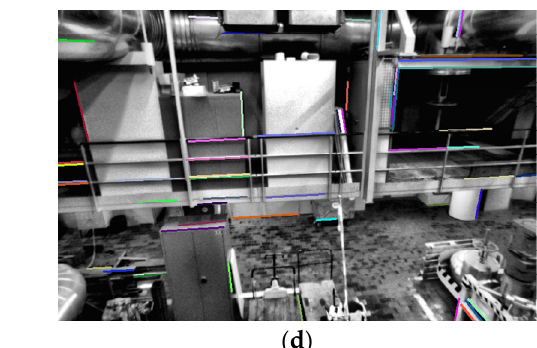
Figure 6. Comparison of the matching effect between line binary descriptors (LBD) matching method and improved matching method on the MH_02_easy dataset. Images ( a , b ) are LBD descriptor matching scenes—the line of the same color is the corresponding matching line; ( c , d ) are the matching scenes of the improved matching method, and the line of the same color is the corresponding matching line.